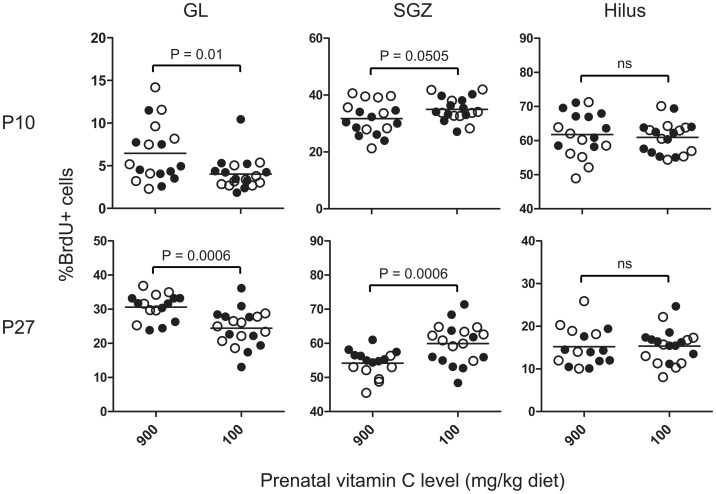
Prenatal vitamin C deficiency causes sustained reduction in postnatal migration of newborn cells into the granule layer.Evaluation of migration pattern of newborn cells according to their location in the different parts of the dentate gyrus at P10 and P27. Results are presented as the percentage of BrdU-positive cells counted in each region. Prenatally-deficient animals were compared to prenatally-sufficient animals by Two-way ANOVA. Closed circles (•) represent high and open circles (○) represent low postnatal vitamin C. N = 7–11 per treatment group. Significantly different mean values are indicated by their respective P-values in the graph; ns indicates no significant difference.